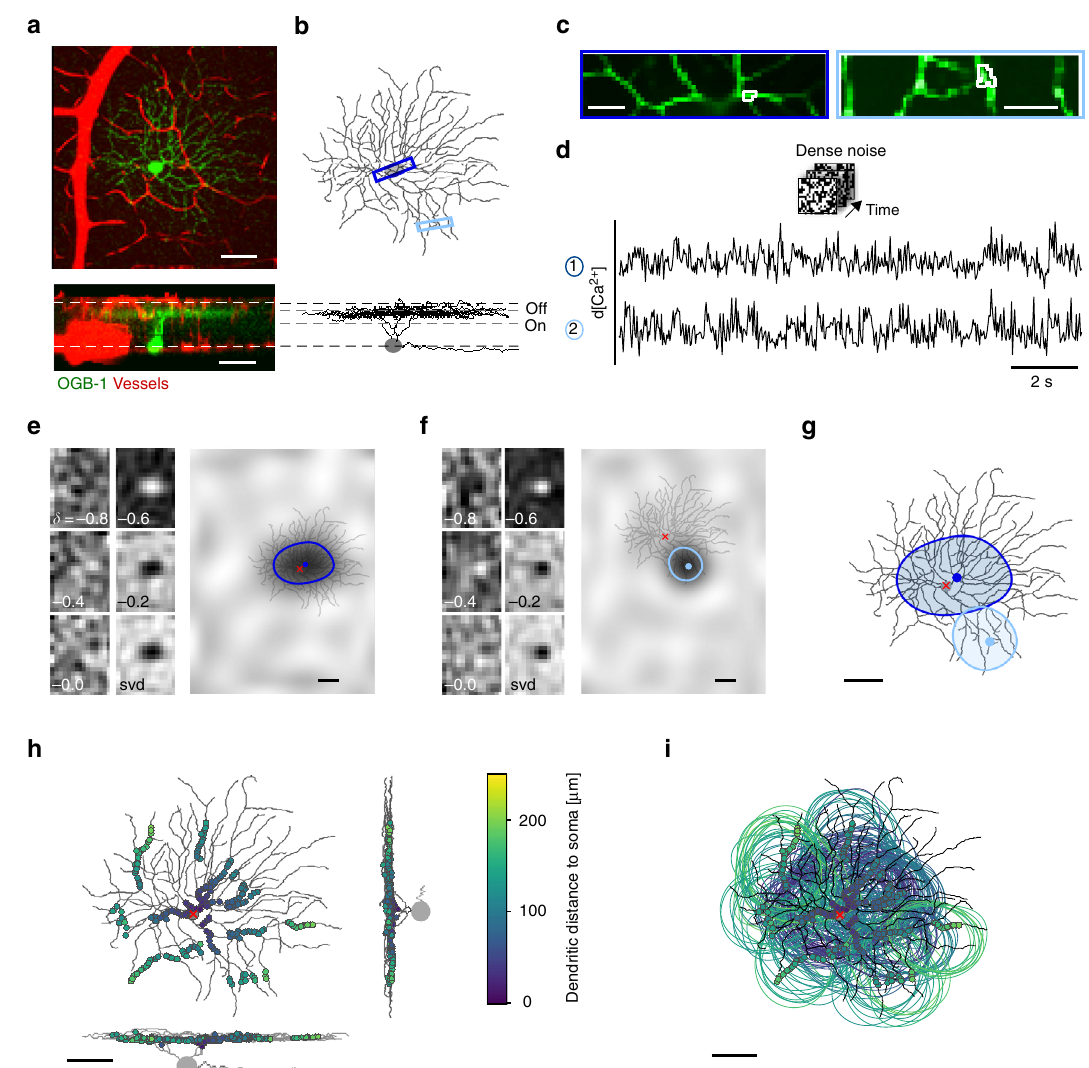
Fig. 1 Recording dendritic receptive fi elds (RFs) in individual retinal ganglion cells (RGCs). a Z -projection of an image stack showing an Off-transient RGC fi lled with the synthetic Ca 2 + indicator Oregon green BAPTA-1 (OGB-1; green) and blood vessels (red) in top view (top) and as side view (bottom). Dashed white lines mark blood vessels at the borders to ganglion cell layer (GCL) and inner nuclear layer (INL). b Reconstructed morphology of cell from a . Dashed grey lines between vessel plexi indicate ChAT bands. c Example scan fi elds, as indicated by blue rectangles in b , with exemplary region of interest (ROI; white) each. d De-trended Ca 2 + signals from ROIs in c during dense noise stimulation (20 × 15 pixels, 30 µ m per pixel, 5 Hz). e Smooth spatial receptive fi eld (RF) maps from automatic smoothness detection (ASD) for left ROI in c at different times ( δ , [s]) before an event and singular value decomposition (svd; Methods) map (left). Up-sampled RF map overlaid with the cell ’ s morphology (right; red crosshair indicates soma position), ROI position (blue dot) and RF contour. f Like e but for right ROI in c . g RF contours of ROIs from e , f overlaid on the reconstructed cell morphology. h Top- and side-view of example cell with all analysed ROIs ( n = 15 scan fi elds, n = 193 of 232 ROIs passed the quality test; see Methods and Supplementary Fig. 1a, b), shown as dots and colour-coded by dendritic distance from soma. i RF contours of ROIs from h . Scale bars: a , b , e – i 50 µ m, c 10 µ